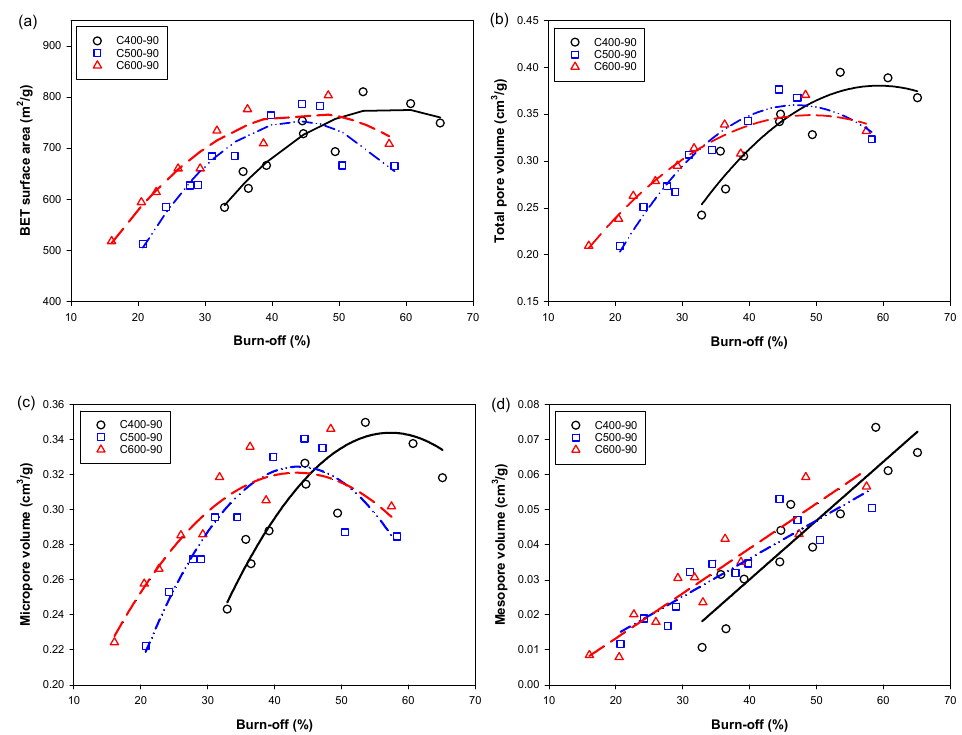
Figure 5. Effects of char burn ‐ off on porous properties of the prepared activated carbons. ( a ) BET surface area, ( b ) total pore volume, ( c ) micropore volume, and ( d ) mesopore volume.